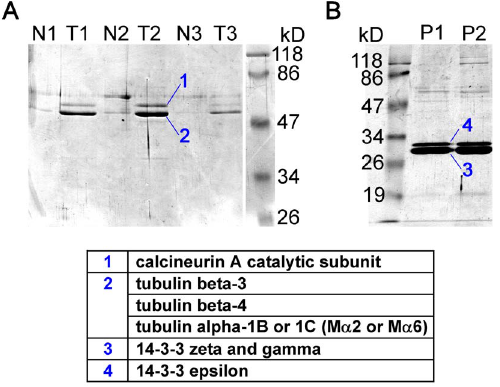
Figure 1. Calcineurin, tubulin and 14-3-3 are the major proteins binding to TRESK-loop-His 8 in affinity chromatography exper- iments. A. Mouse brain proteins, remaining on the columns after the NaCl gradient, were eluted with 7 M urea. Three fractions from the Ni- NTA control column (N1–N3) and from the column containing TRESK- loop-His 8 (T1–T3) were analyzed by SDS-PAGE and Coomassie Blue staining. The two intense bands from fraction T2 were identified by mass spectrometry as calcineurin and tubulin (as indicated in the table below the gel). B. TRESK-loop-His 8 (immobilized on Ni-NTA resin) was phosphorylated with protein kinase A (PKA) before the affinity chromatography. The phosphorylated bait protein interacted with different 14-3-3 isoforms (see band 3 and 4; P1 and P2 lanes represent two independent